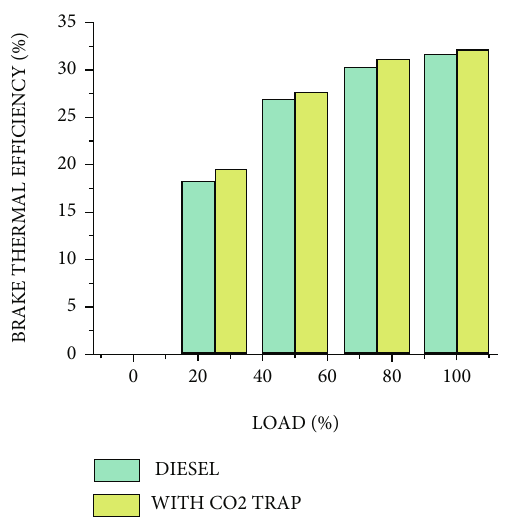
Figure 9: Variation of brake thermal e ffi ciency with respect to engine